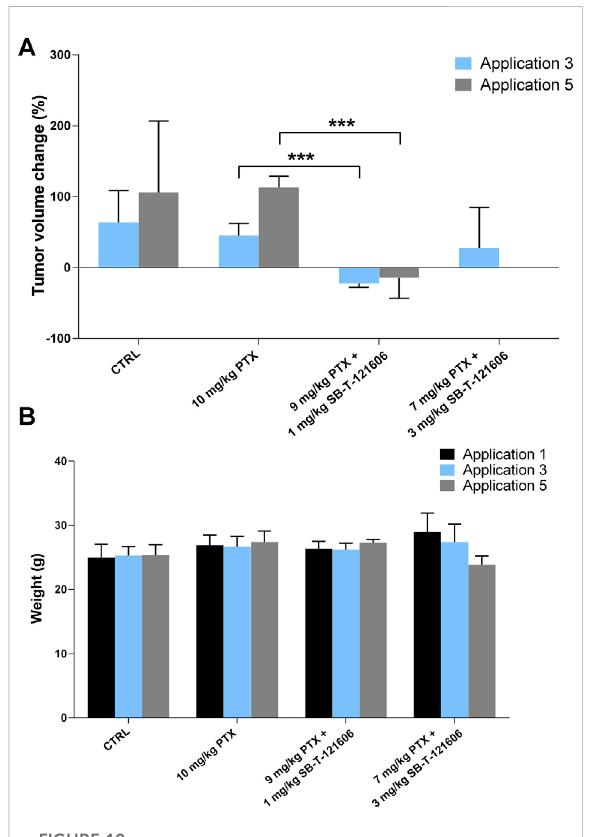
FIGURE 10 In vivo ef fi cacy of SB-T-121606. (A) Changes of tumor volume (%) during experiment in comparison to tumor volume before the fi rst application. Ef fi cacy was compared between control group, experimental group treated with a/10 mg/kg PTX alone, b/combinations of 9 mg/kg PTX with 1 mg/kg SB-T- 121606 and c/7 mg/kg PTX with 3 mg/kg SB-T-121606. (B) Changes of mouse weight (g) during the application in all examined experimental groups. * p -values by two-tailed Student ’ s t-test (*** p ≤ 0.001).